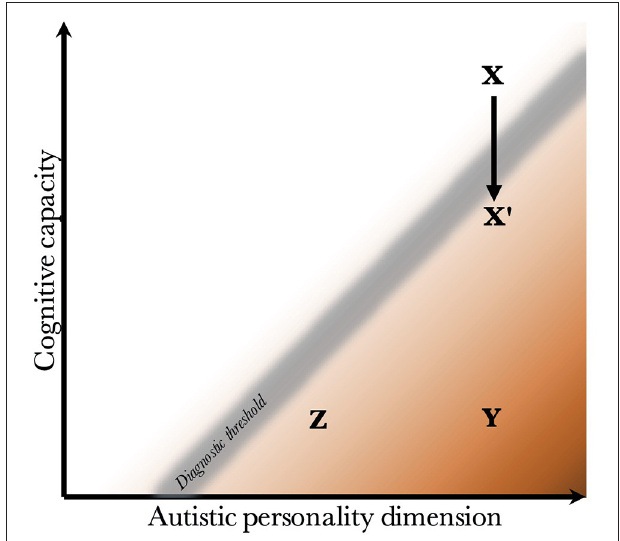
FIGURE 3 | Examples of individuals with varying degrees of cognitive capacity and autistic personality. Presentation of three individuals and their observed phenotypes. Individual X has a high cognitive capacity, which fully compensates for the presence of a pronounced autistic personality. Although X may be perceived as socially odd, no diagnosis is warranted since X is above the diagnostic threshold. Individual Y has an equally pronounced autistic personality. However, the cognitive capacity is much lower, and doesn’t allow for adequate compensation of its autistic features. Y fulfills diagnostic criteria, and likely has a moderate to severe autism (long distance to diagnostic threshold). Individual Z also has a low cognitive capacity, which is unable to compensate adequately. However, Z has a milder autistic personality than Y, leading to a milder autistic phenotype (smaller distance to the diagnostic threshold). Finally, X’ represents individual X following a neurological insult that negatively affects cognitive capacity. One can imagine X being conceived by healthy parents with a genetic architecture that supports high cognitive capacity and a pronounced autistic personality, but having experienced a perinatal complication or an insult during childhood. The insult lowers the cognitive capacity enough to impair compensation, leading to a diagnosis of